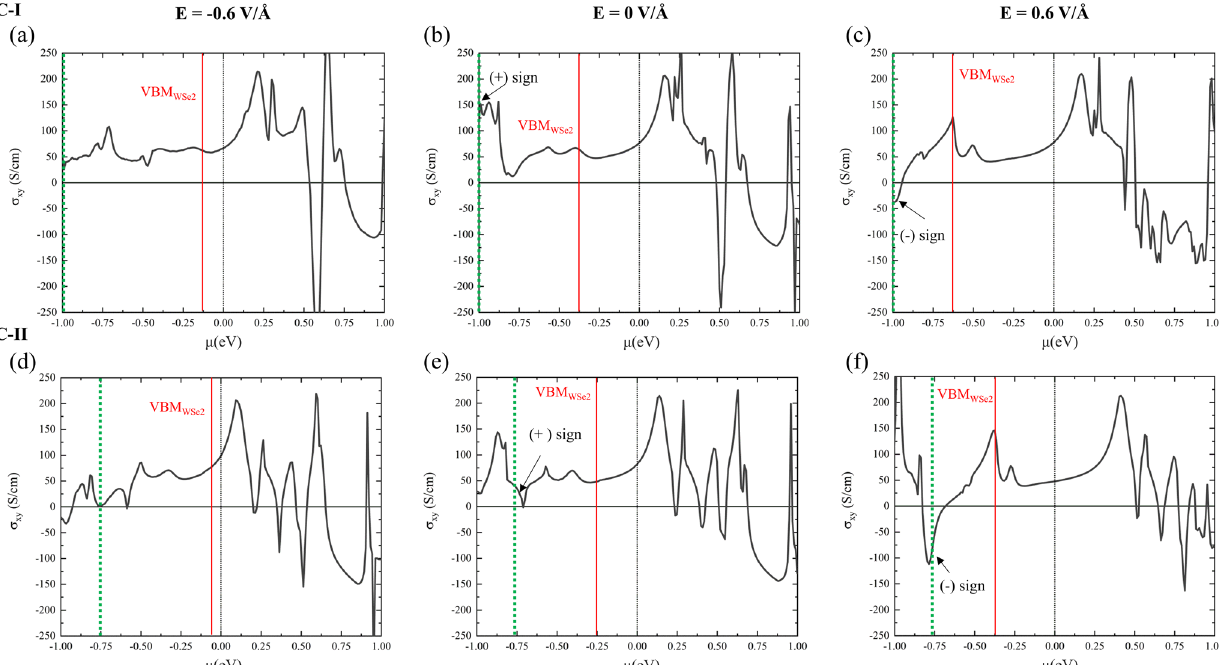
Fig. 4 Electric fi eld-dependent anomalous Hall conductivity. Electric fi eld-dependent anomalous Hall conductivity ( σ xy ) as a function of chemical potential ( μ ) for C-I stacking at a E = − 0.6 V Å − 1 , b E = 0 V Å − 1 , c E = 0.6 V Å − 1 , and for C-II stacking at d E = − 0.6 V Å − 1 , e E = 0 V Å − 1 , and f E = 0.6 V Å − 1 . The gray vertical dashed line represents the Fermi energy. The green vertical dashed lines represent the chemical potential ( μ ) of − 1 eV in C-I stacking and − 0.75 eV in C-II stacking. The red solid lines represent the VBM of the WSe 2